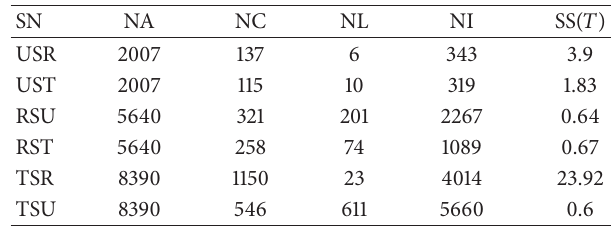
Table 1: The score of the PCN. Table 2: The score of the